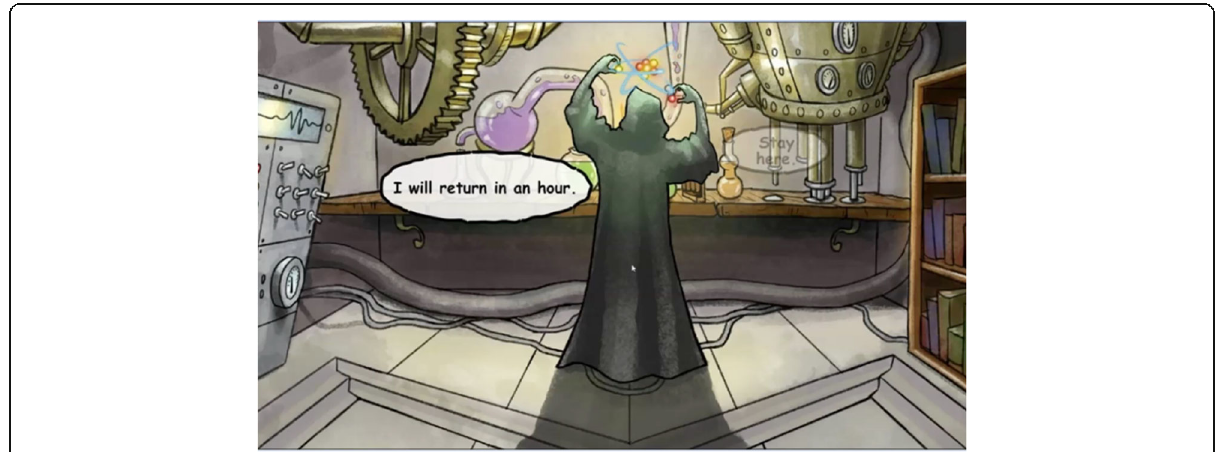
Fig. 3 Inside the Lightning Master ’ s lab, sample cut